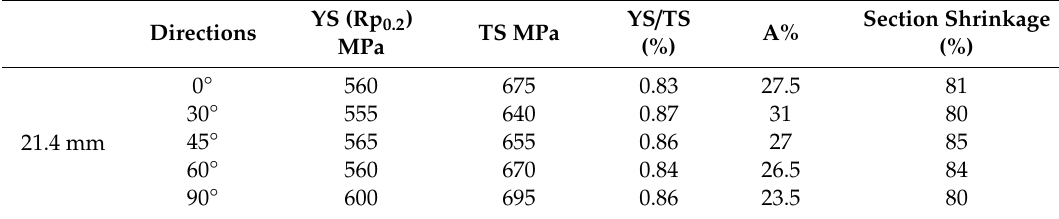
Table 2. Mechanical proprieties of high-strength pipeline steel in di ff erent directions.